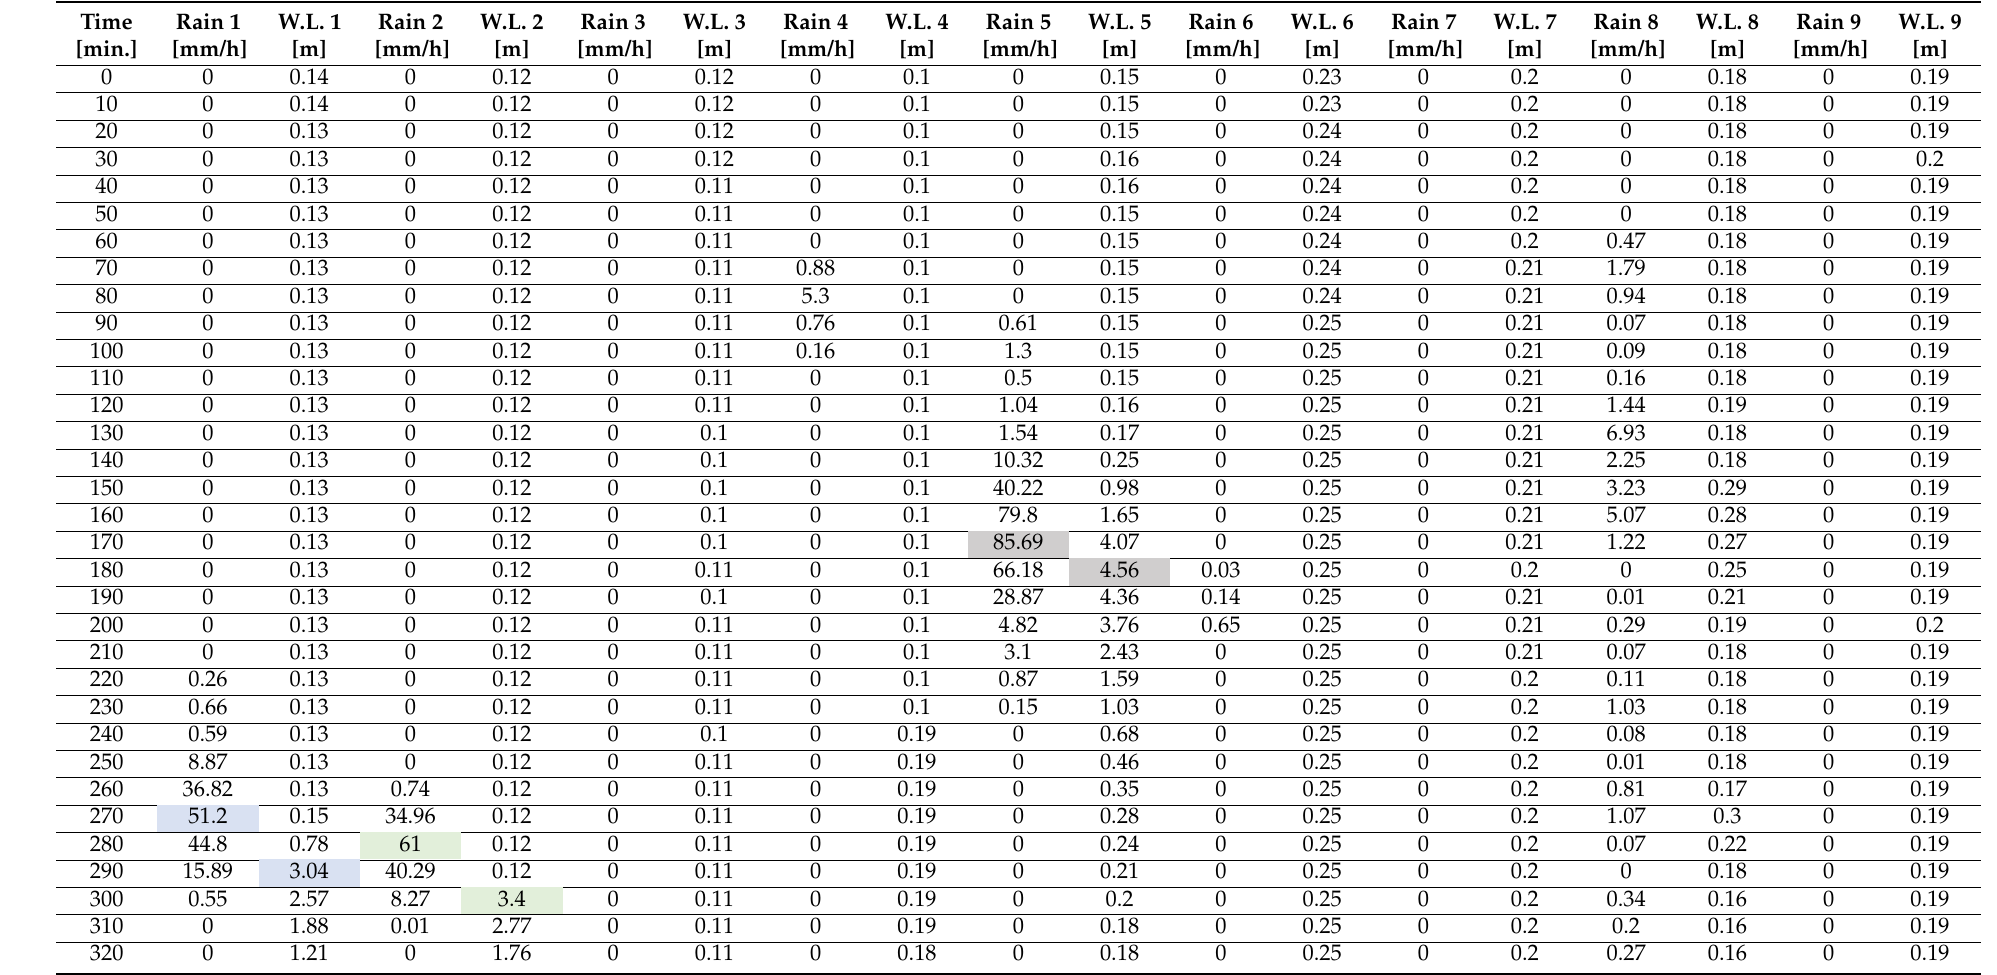
Table 1. Observed numerical data on rainfall and water levels at each event, with colored maximum rainfall intensity and water level for each